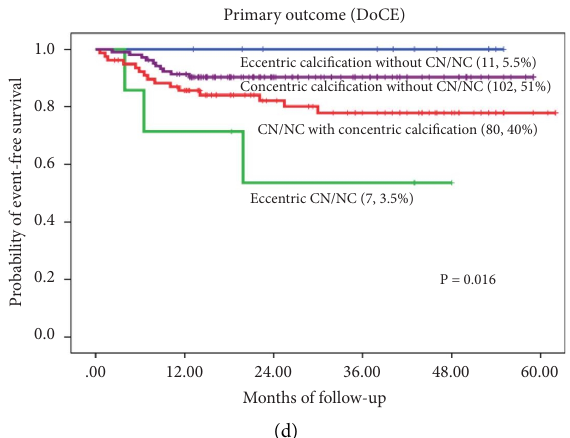
Figure 3: Central illustration. Drawing and IVUS results pre- and post-stent implantation, comparison of primary outcome according to calcifc plaque and characteristic and pattern of calcifed nodule/nodular calcifcation are presented. (a) Drawing and IVUS imaging showed pre- and post-stent for concentric calcifcation with calcifed nodule/nodular calcifcation. (b) Drawing and IVUS imaging showed pre- and post-stent for an eccentric calcifed nodule/nodular calcifcation. (c) A forest plot showing the adjusted hazard ratios and 95% confdence intervals for the primary outcome. (d) Kaplan-Meier survival analysis for the primary outcome after RA-assisted intravascular ultrasound (IVUS)-guided PCI compared among diferent subtypes of calcifc plaque and calcifed nodule/nodular calcifcation characteristics. IVUS: intravascular ultrasound; DoCE: device-oriented composite endpoint; RA: rotational atherectomy; PCI: percutaneous coronary in- tervention; CN: calcifed nodule; and NC: nodular